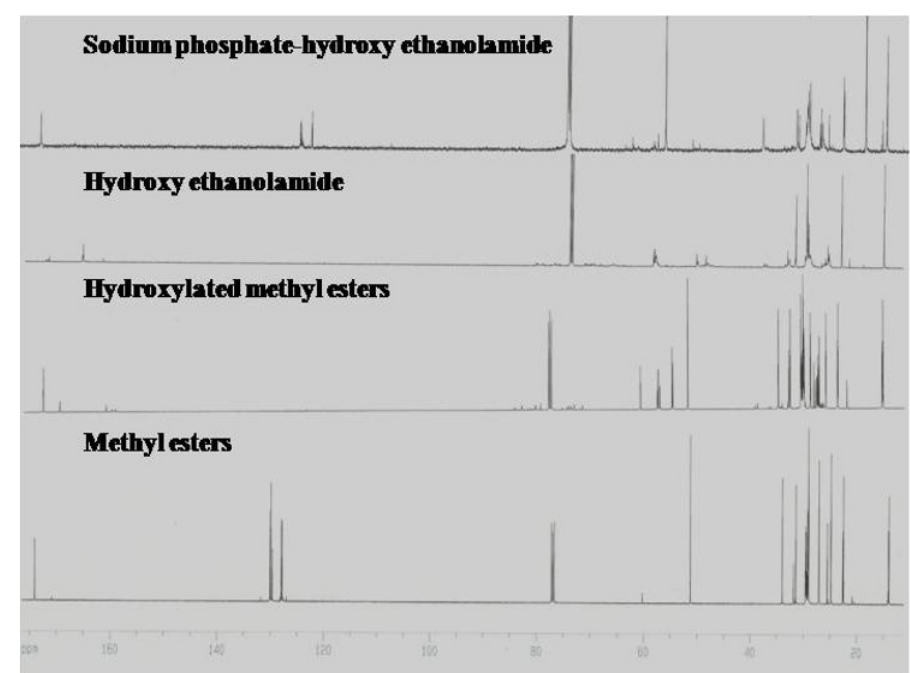
Figure 3. 13 CNMR spectra of the methyl esters, hydroxylated methyl esters, hydroxy ethanolamide and sodium phosphate-hydroxy ethanolamide of luffa cylindrica